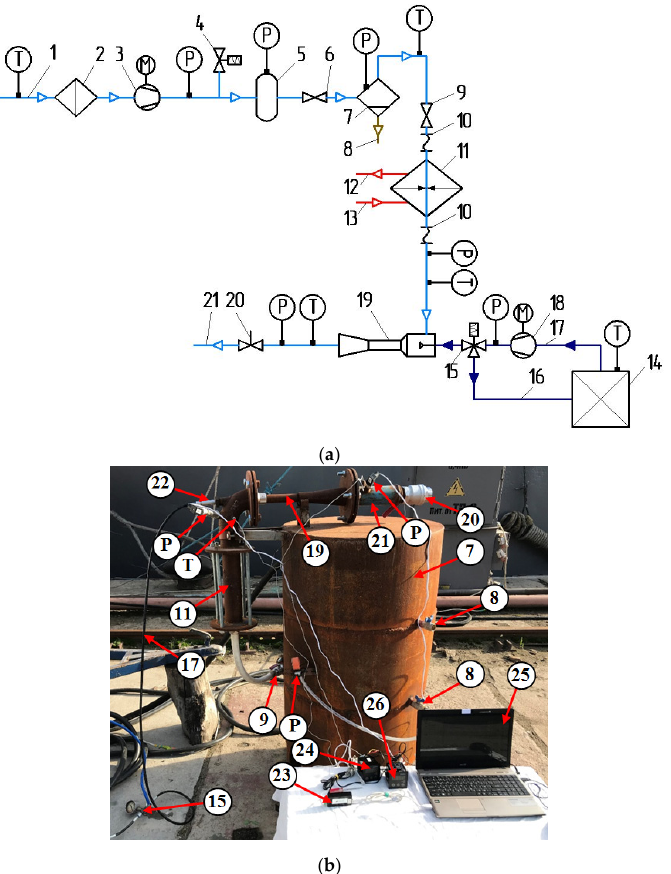
Figure 3. Experimental setup for studying the thermopressor characteristics: scheme ( a ); experi- mental setup photo ( b ): 1—inlet pipeline; 2—air filter; 3—screw compressor; 4—safety valve; 5—air